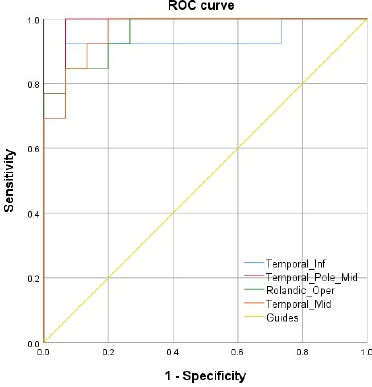
Figure 5. ROC curve. The AUCs were: 0.924 for Temporal-Inf, 0.979 for Temporal-Pole-Mid, 0.965 for Rolandic-Oper, and 0.951 for Temporal-Mid.